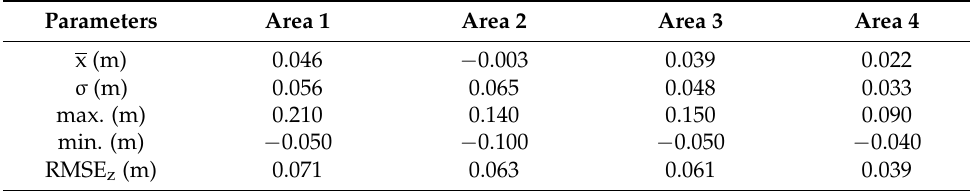
Table 4. Result of statistical parameters of DEM altimetric validations.